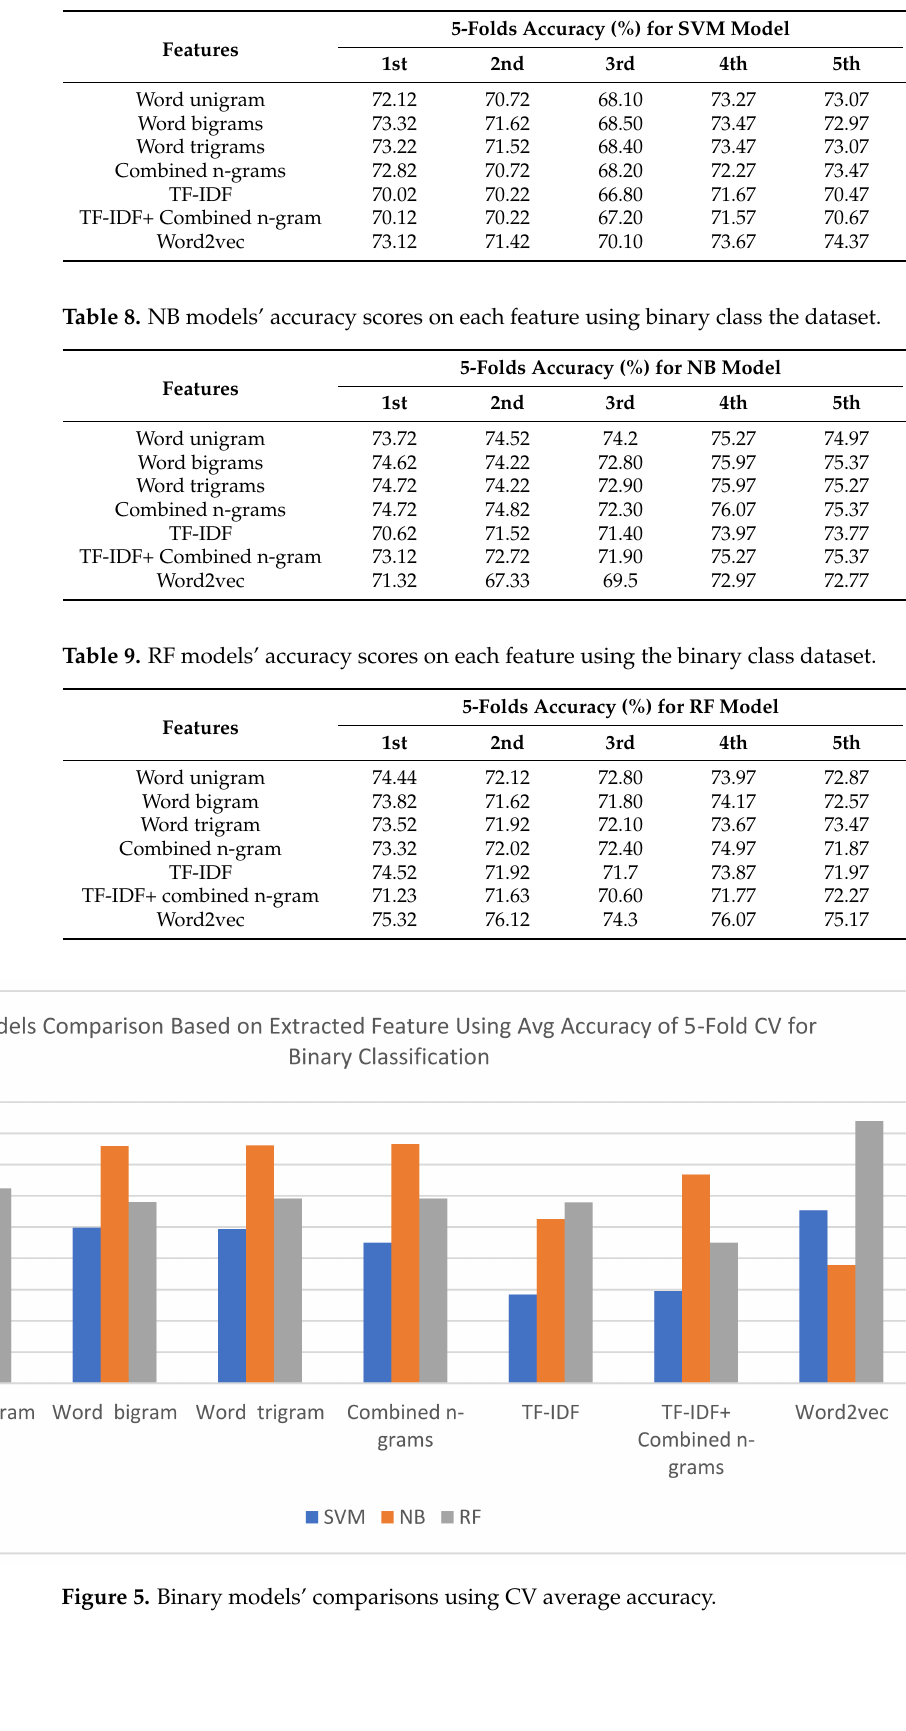
Table 7. SVM models’ accuracy scores for each feature using the binary class dataset.